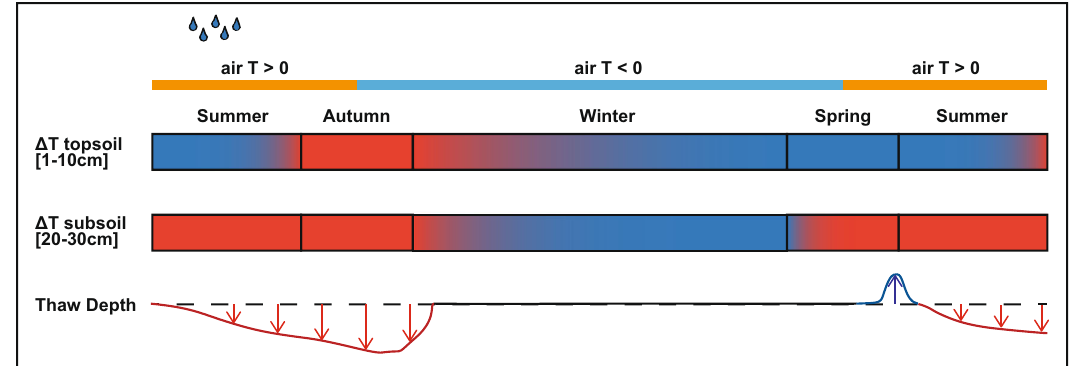
Fig. 4 Conceptual diagram of the effect of extreme rainfall on the soil thermal regime. Schematic representation of the soil thermal regime under increased rainfall throughout the year and the following summer season, based on fi eld observations and model results (Fig. 1 and Supplementary Figs. 8, 16 and 17). The top two bars represent temperature differences in the organic topsoil (0 – 10 cm depth) and mineral subsoil (20 – 30 cm depth) relative to a situation with average rainfall. Red colours indicate warmer temperatures under extreme rainfall and blue colours represent colder temperatures under extreme rainfall. The bottom line represents differences in thaw depth compared to a situation with average rainfall, with red downward arrows representing deeper thaw, blue upward arrows indicating shallower thaw and black colours representing no thaw depth (fully frozen soil). The effects of extreme rainfall vary by depth, with topsoils exhibiting evaporative cooling and persistent warming throughout autumn and early winter, whereas subsoils show warming in summer and cooling in